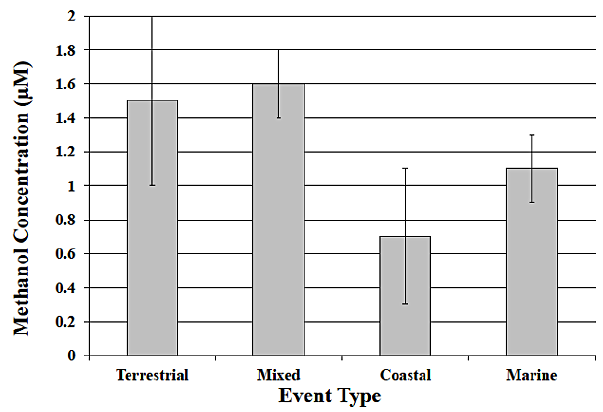
Figure 1. Average volume-weighted methanol concentrations plot- ted according to rain event origin. Error bars represent ± one stan- dard deviation from the average.